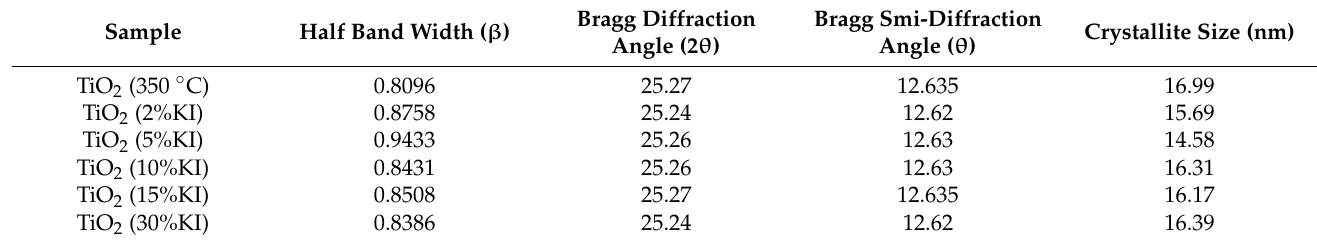
Table 1. Effect of doping with I on the crystallite size of TiO 2 .